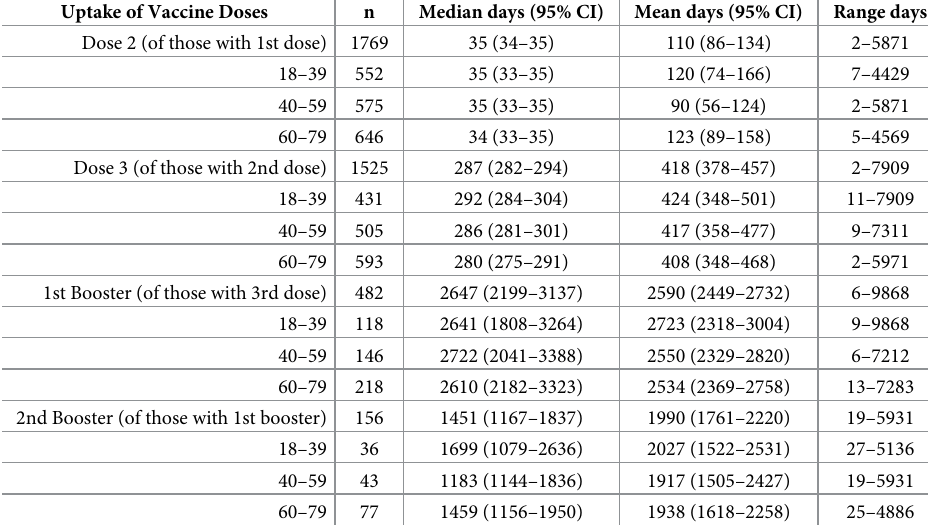
Table 3. Timing of TBE vaccine